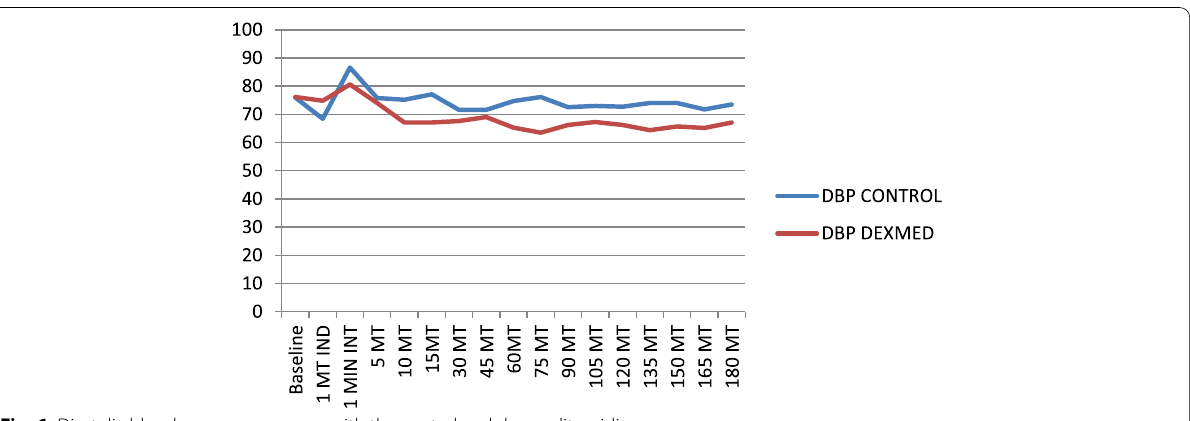
Fig. 6 Diastolic blood pressure response with the control and dexmeditomidine groups